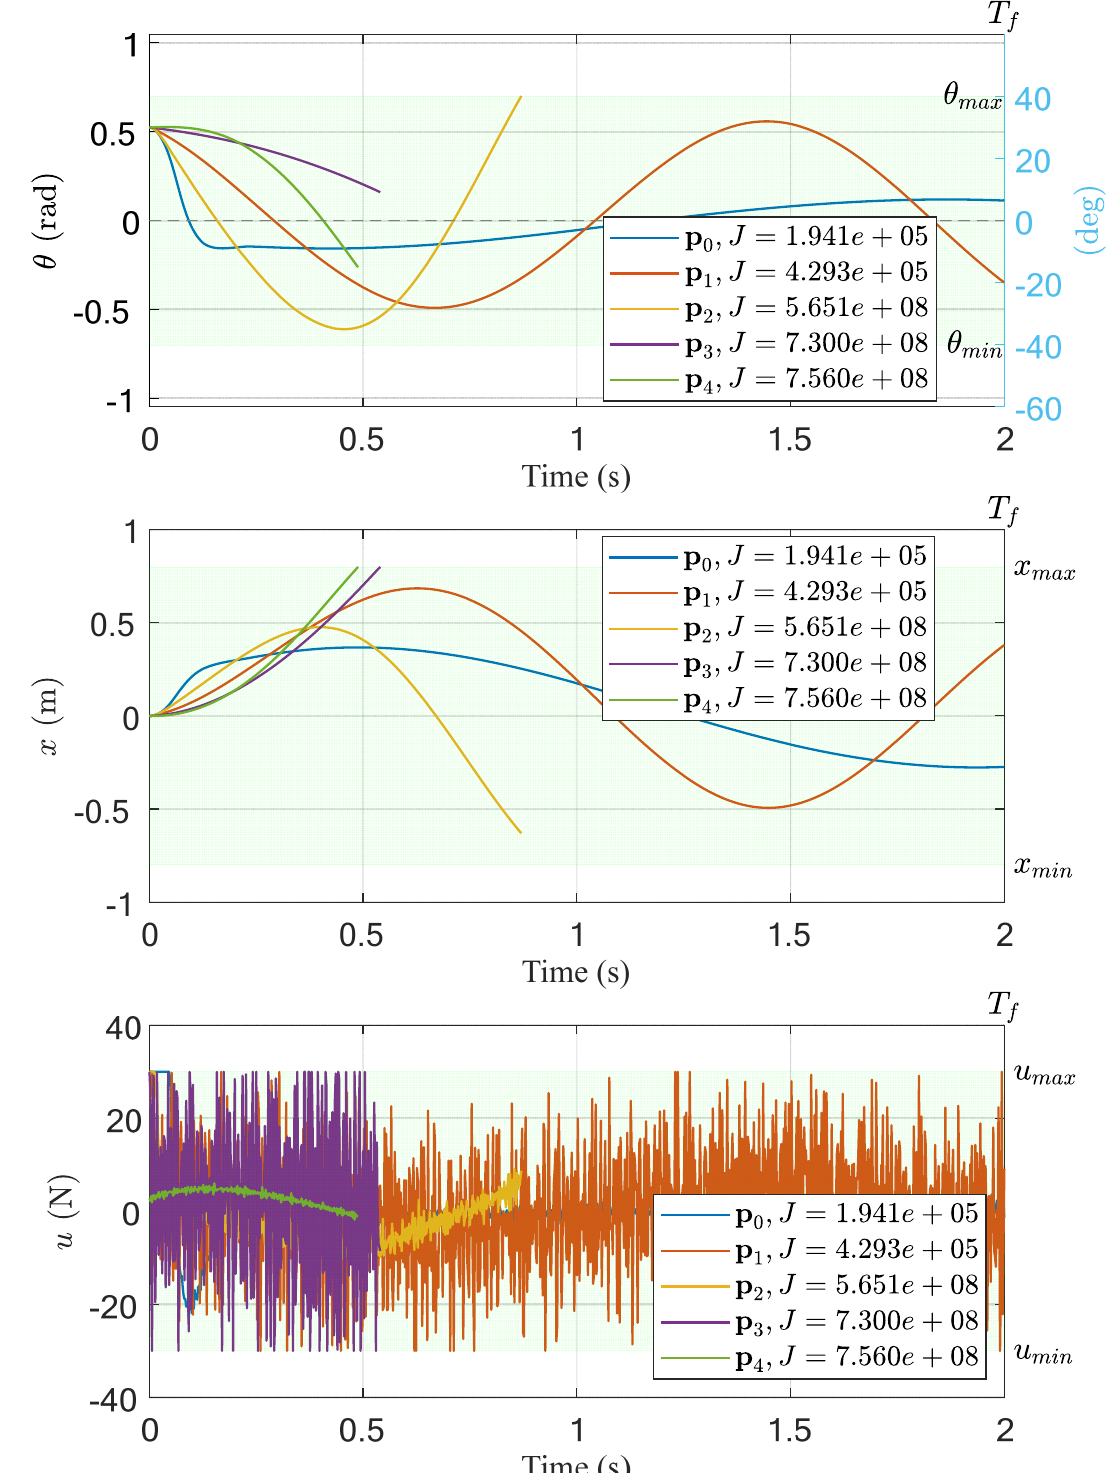
Figure 2. Time responses of the inverted pendulum system controlled by the five sets of controller parameters given in Table 2.